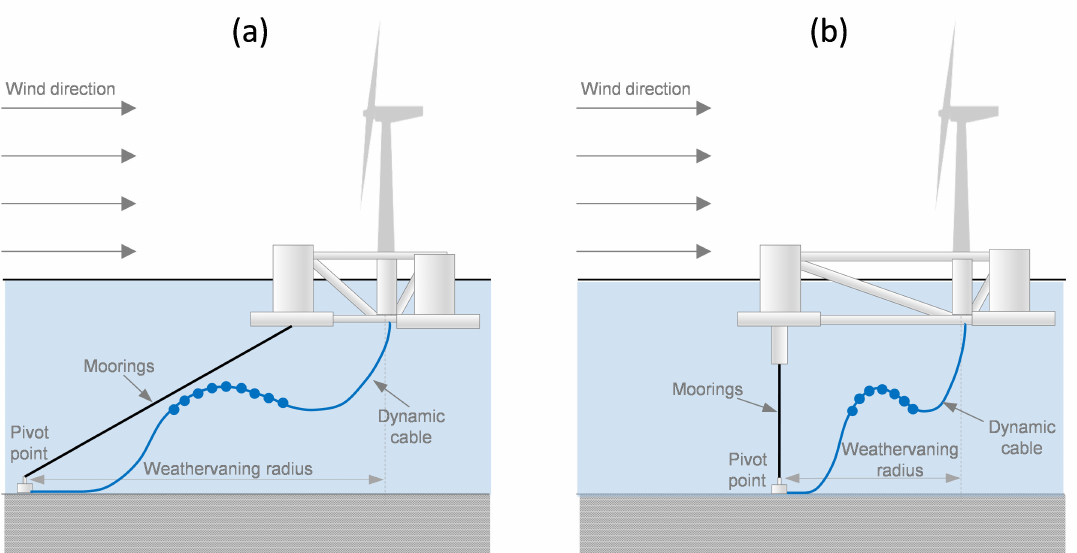
Figure 1. Outline of the two technological options currently under development for offshore weathervaning floating wind turbines: pivot point located away from the horizontal plane of the floating platform ( a ) or located on the same plane ( b